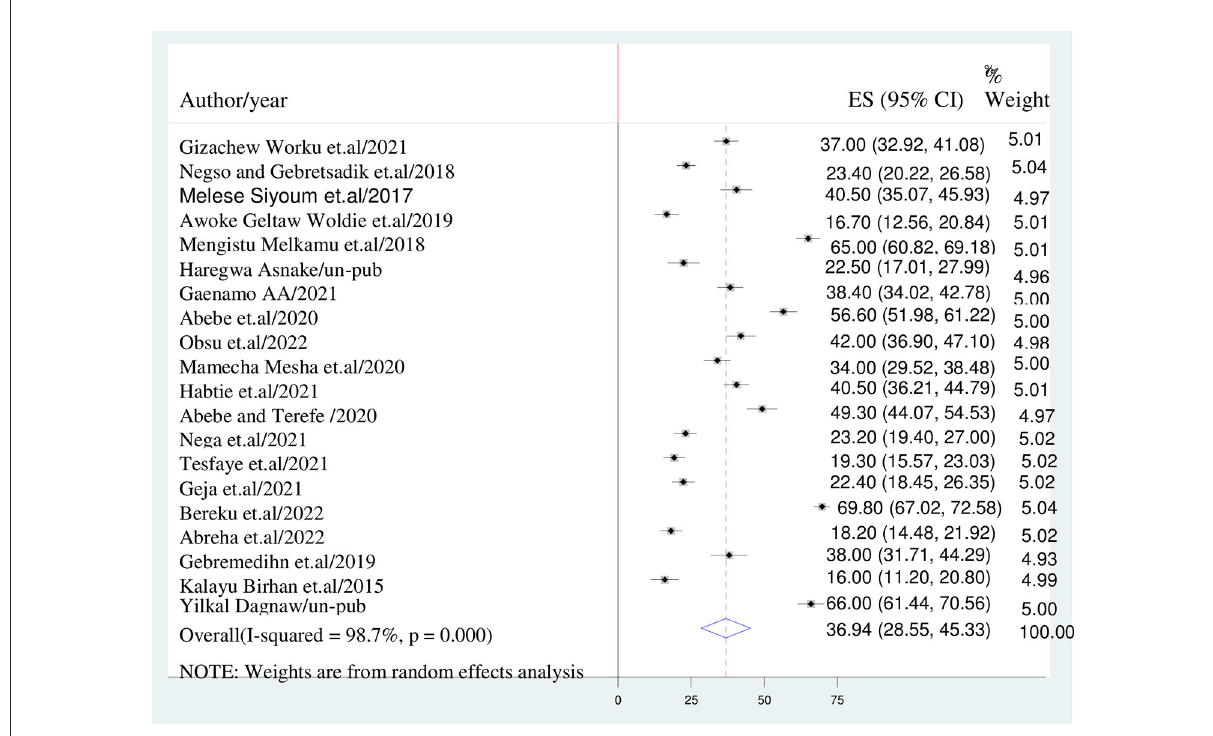
FIGURE2 Forest plot displaying of discontinuation of long acting reversible contraceptives.